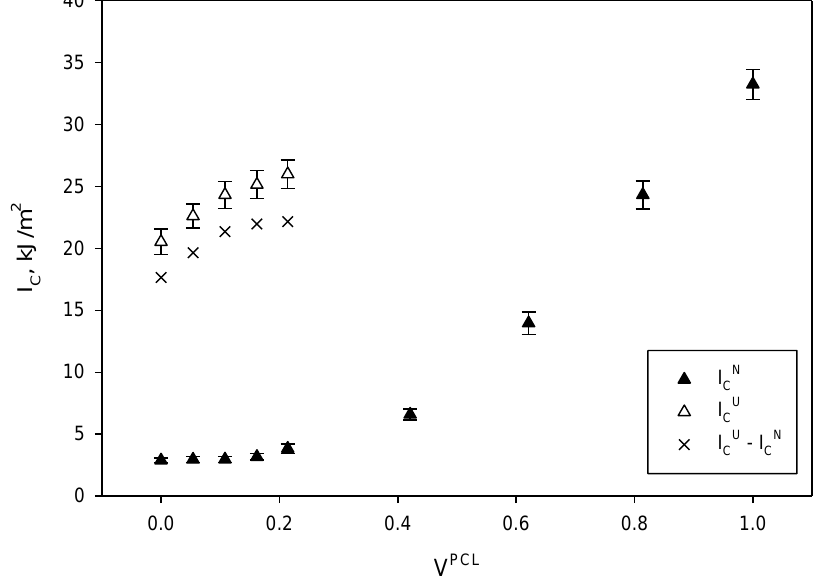
Figure 8. Impact resilience of Charpy notched and unnotched impact strengths of the PLA / PCL blends and fracture creation energy (I CU − I CN ).